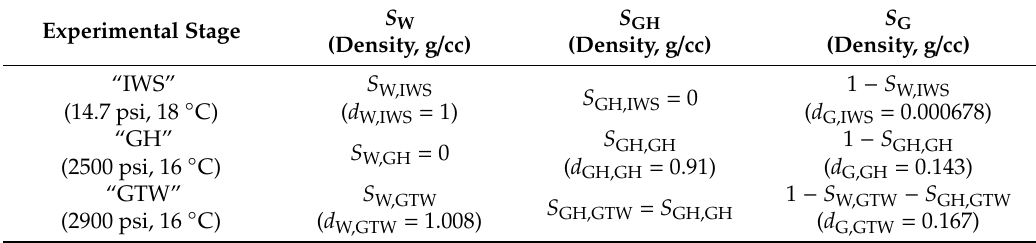
Table 1. Saturation and density conditions for labeling in the three experimental stages. Experimental